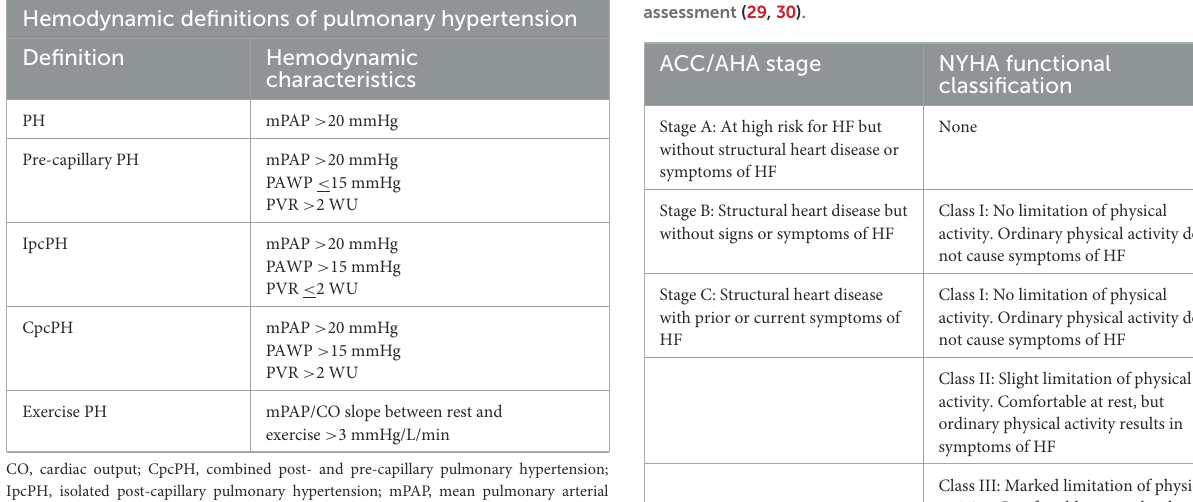
TABLE 3 ESC guidelines on PH definition based on hemodynamic characteristics (11).